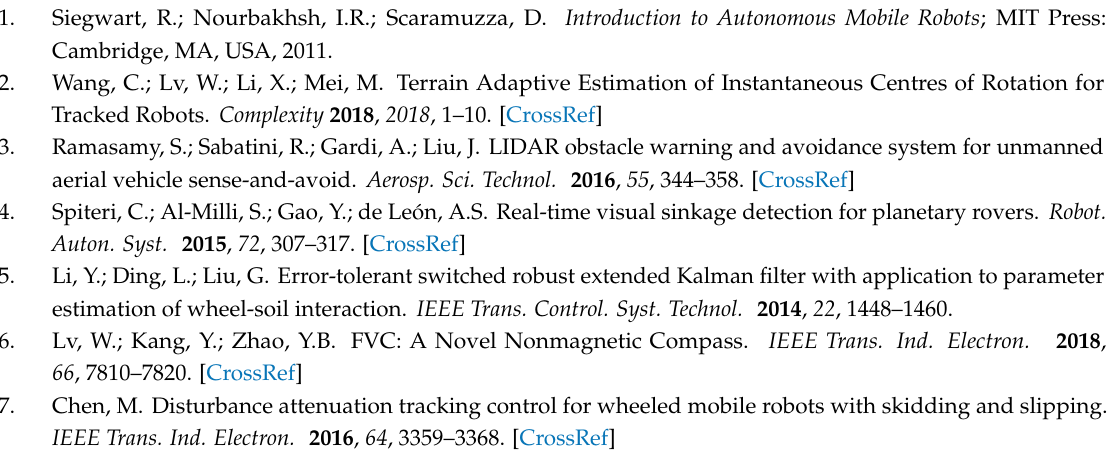
Figure 12. Classification accuracies of p-LapSVM over T d under LS2 ( k 1 = 6, γ K = 10 − 6 , γ M = 1, t 1 = 0.35, k 2 = 11, t 2 = 0.25, µ =